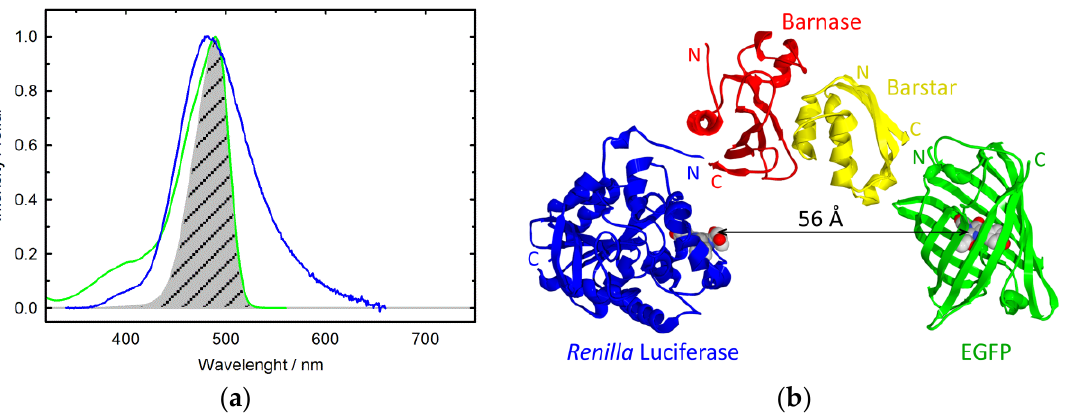
Figure 2. Estimation of the distance between RLuc and EGFP chromophores within the complex of barnase–RLuc and barstar–EGFP: ( a ) Normalized spectra of RLuc bioluminescence (blue), EGFP absorption (green), and their overlapping integral (shaded); ( b ) Schematic presentation of the complex of barnase and barstar fused with photoproteins. The arrow indicates the evaluated distance between photoprotein chromophores (the crystal structures of the complex barnase–barstar, Renilla luciferase, and EGFP are taken from PDB files 1bgs, 2psj, and 2y0g, respectively, while the presentation was composed using SPDBViewer v4.1.0 software [28]).